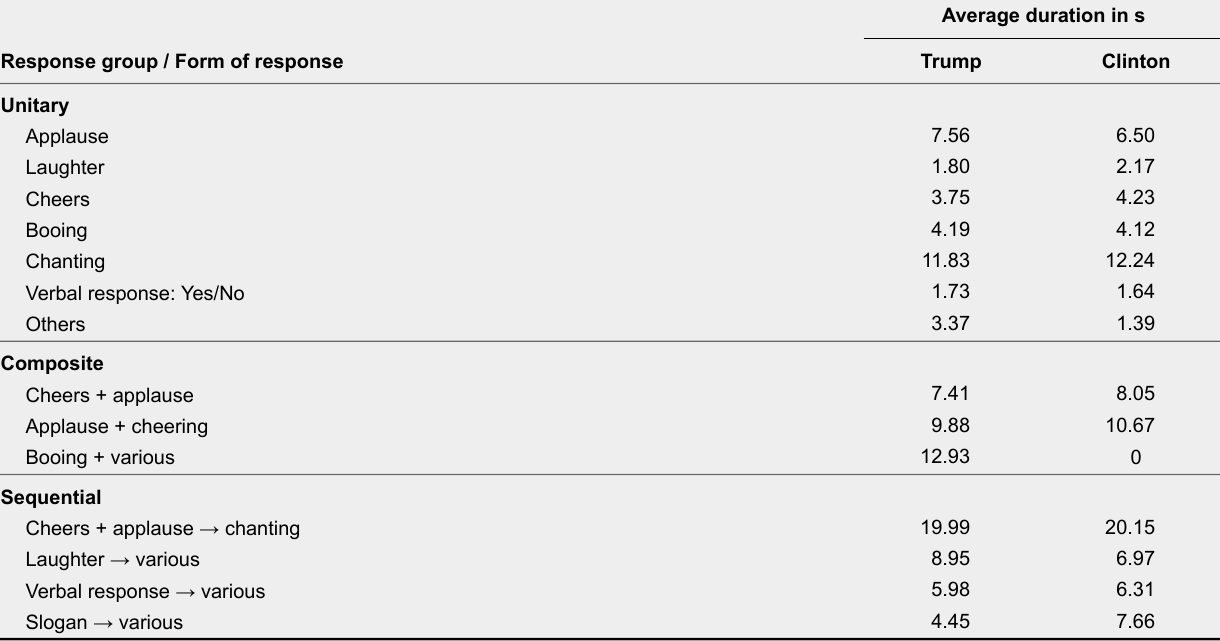
Summary of the Average Duration for Audience Responses Evoked by Each